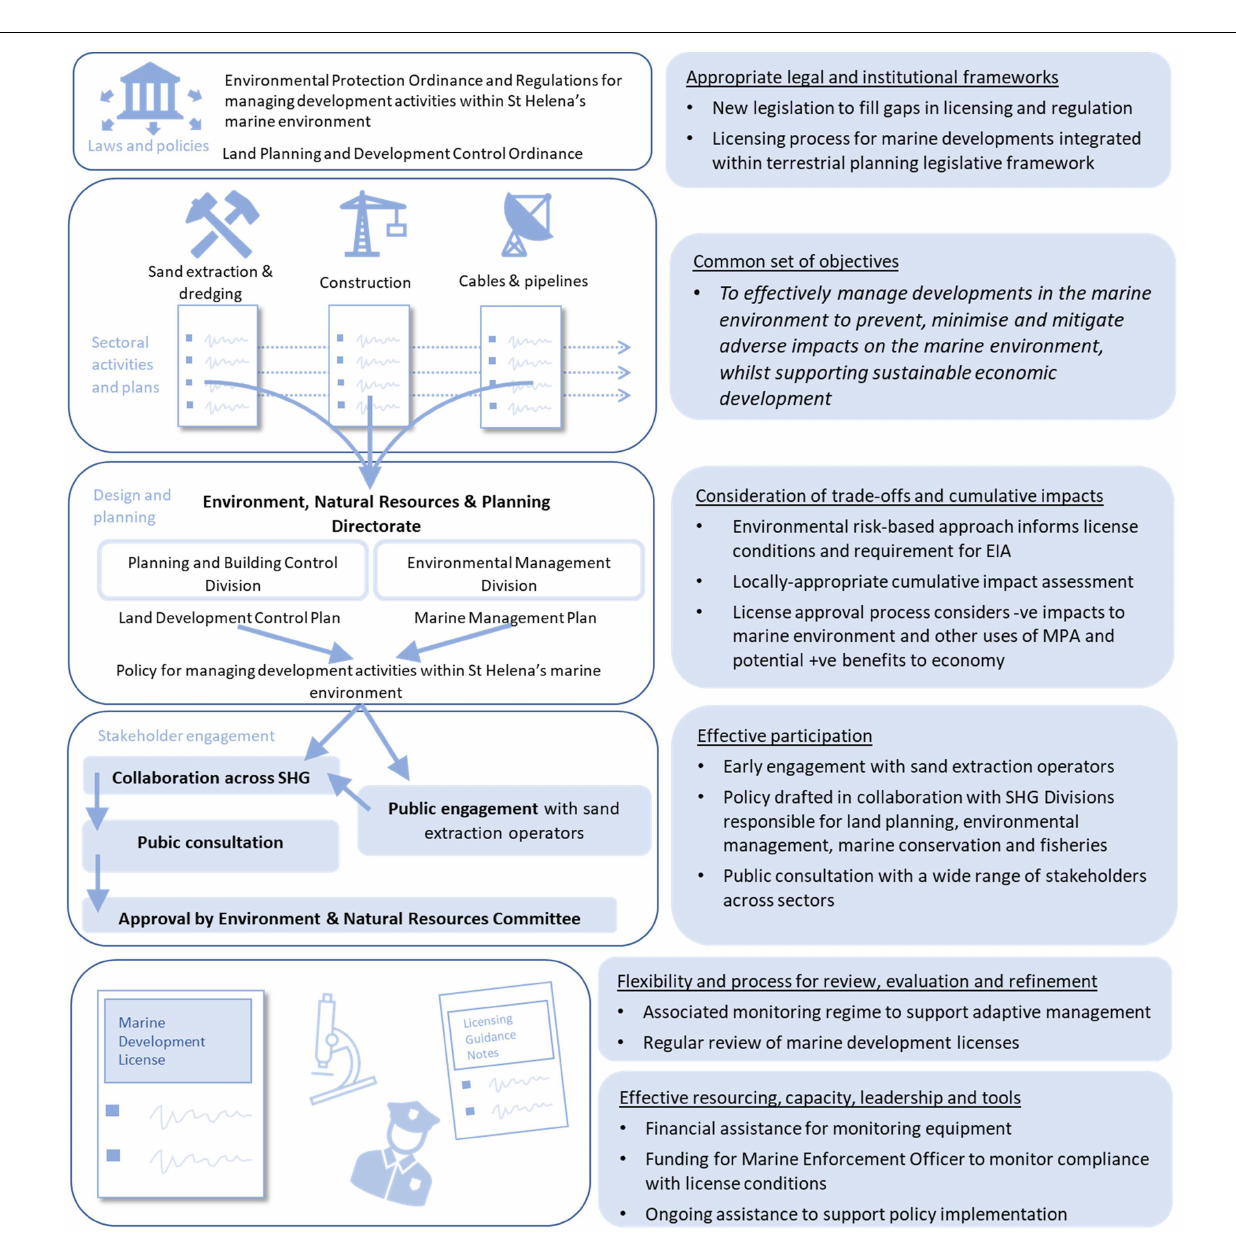
FIGURE 3 | Application of the Integrated Marine Management framework in St